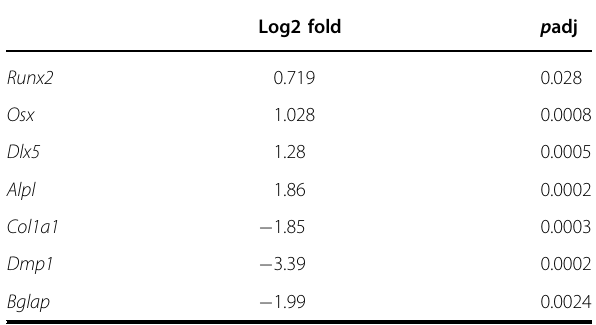
Table 1 Numbers of genes with equal or more than two- fold changes between β -catenin – and control chondrocytes, and between β -catenin – and control C-MPCs.